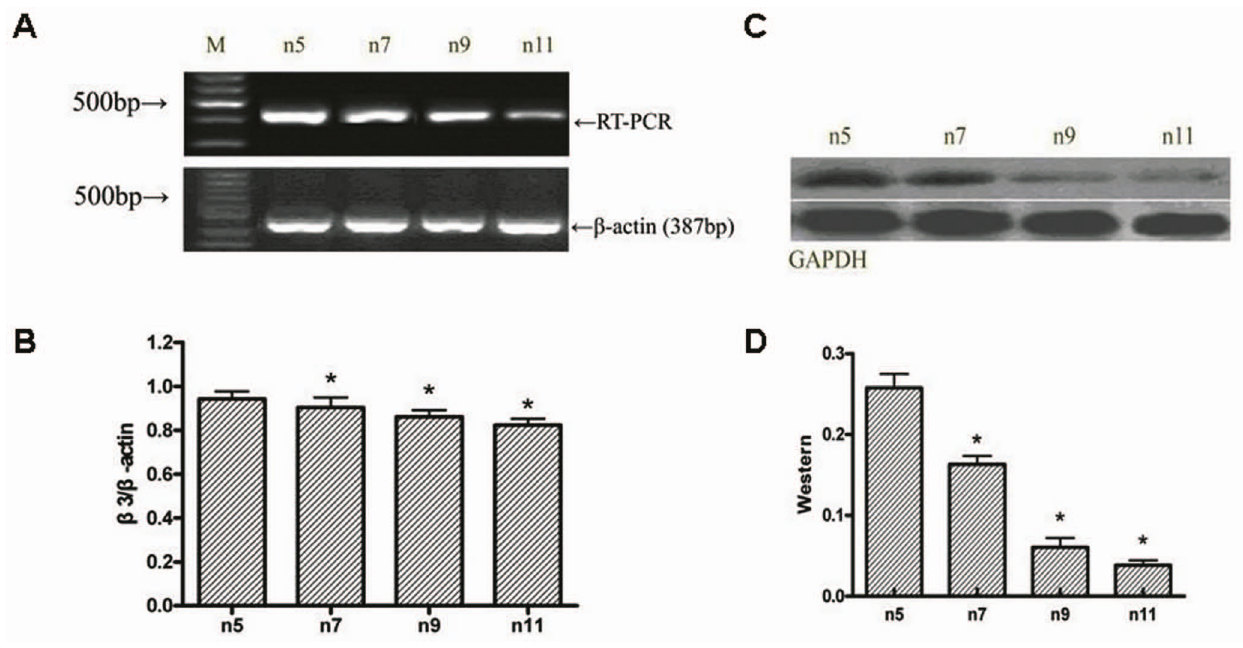
Figure 4. Expression of b 3-AR mRNA by RT-PCR and b 3-AR protein by Western blot in lung. (A) Representative analysis of b 3-AR mRNA level by RT-PCR. Lane M: marker; bp: base pair; lane n5: the 5 th week, non-BRL group; lane n7: the 7 th week, non-BRL group; lane n9: the 9 th week, non-BRL group; lane n11: the 11 th week, non-BRL group. (B) Bar plot showed the data from all animals in the non-BRL group. Data were analyzed by ANOVA. b 3-AR revealed a decrease with the deterioration of heart failure. (* p , 0.05, versus non-BRL group 2 weeks prior to treatment). (C) Immunoblot of b 3-AR protein in representative animals. Lane n5: the 5 th week, non-BRL group; lane n7: the 7 th week, non-BRL group; lane n9: the 9 th week, non-BRL group; lane n11: the 11 th week, non-BRL group. GAPDH: glyceraldehyde phosphate dehydrogenase. (D) Bar plot showed the data from all animals in each group. The data are analyzed by ANOVA. b 3-AR protein revealed a decrease with the deterioration of heart failure. (* p , 0.05, versus non-BRL group 2 weeks prior to treatment). BRL group: HF group with b 3 -AR agonist BRL37344 injection; non-BRL: HF group without BRL37344 injection.